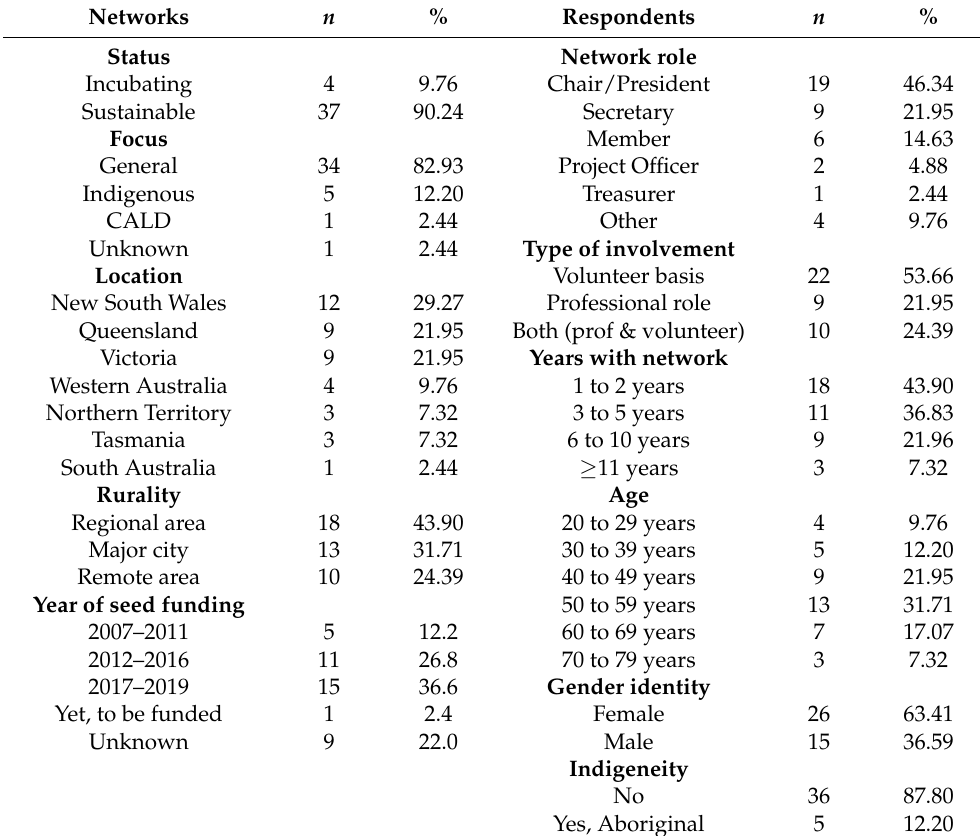
Table 1. Characteristics of participating networks and respondents ( N =